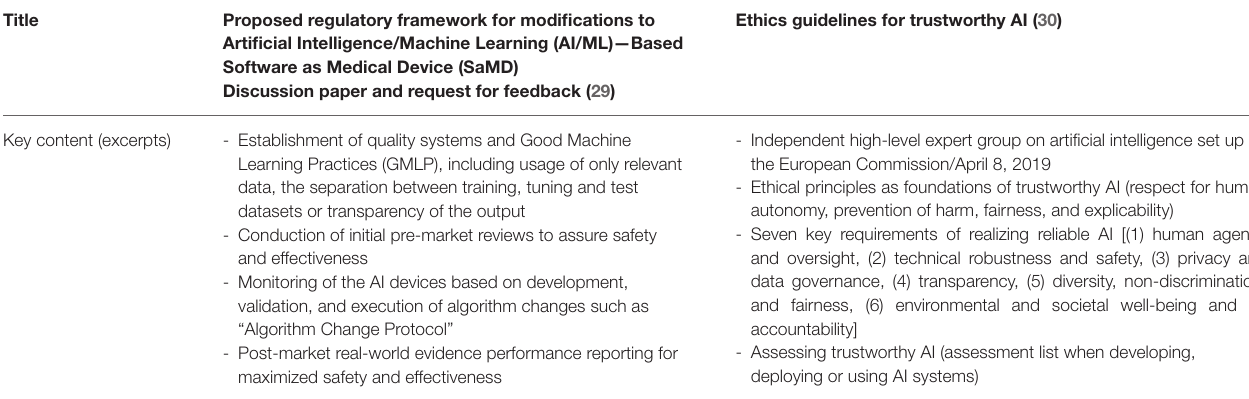
TABLE 1 | Comparison of a US and an EU framework related to AI (29,